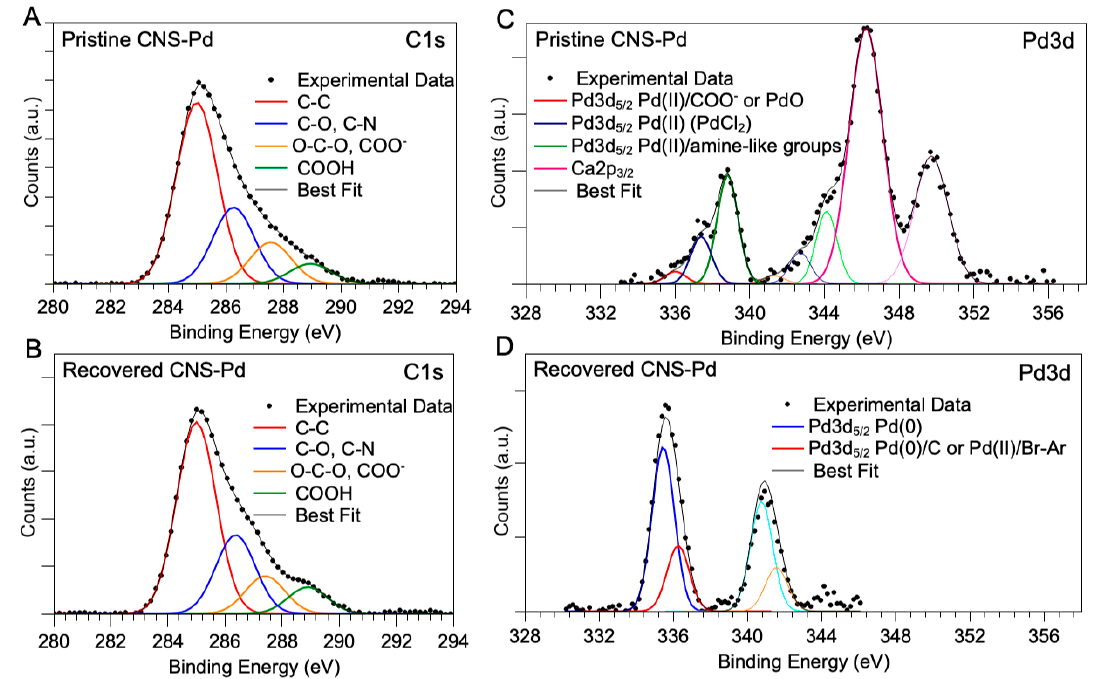
Figure 3. ( A ) XPS C 1s core-level spectra acquired on pristine CNS and ( B ) CNS recovered after catalysis; ( C ) XPS Pd 3d core-level spectra acquired on CNS before and ( D ) after